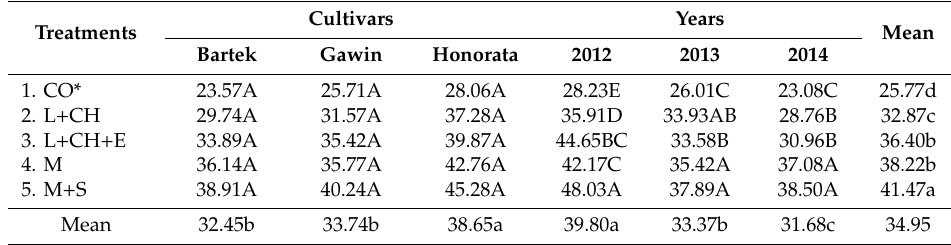
Table 6. Marketable yield of potato tubers (t ha − 1